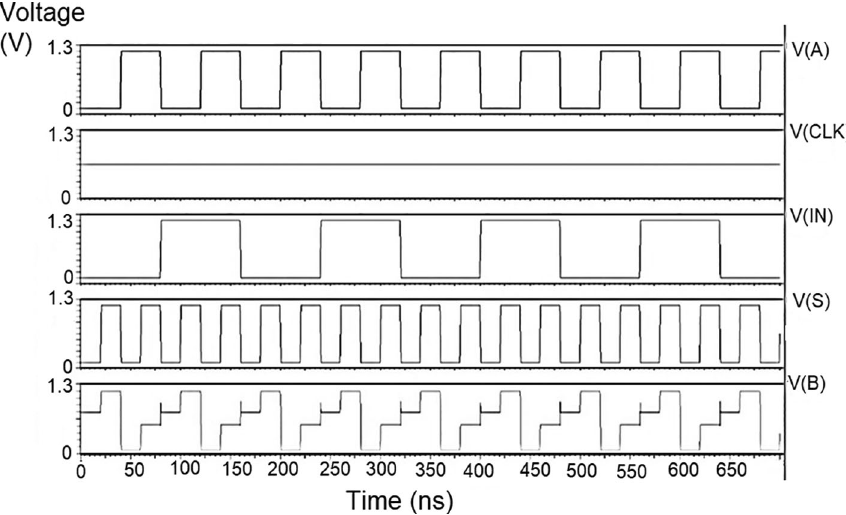
Figure 7(b). Voltage vs time simulation at 1.3 V for 180 nm.